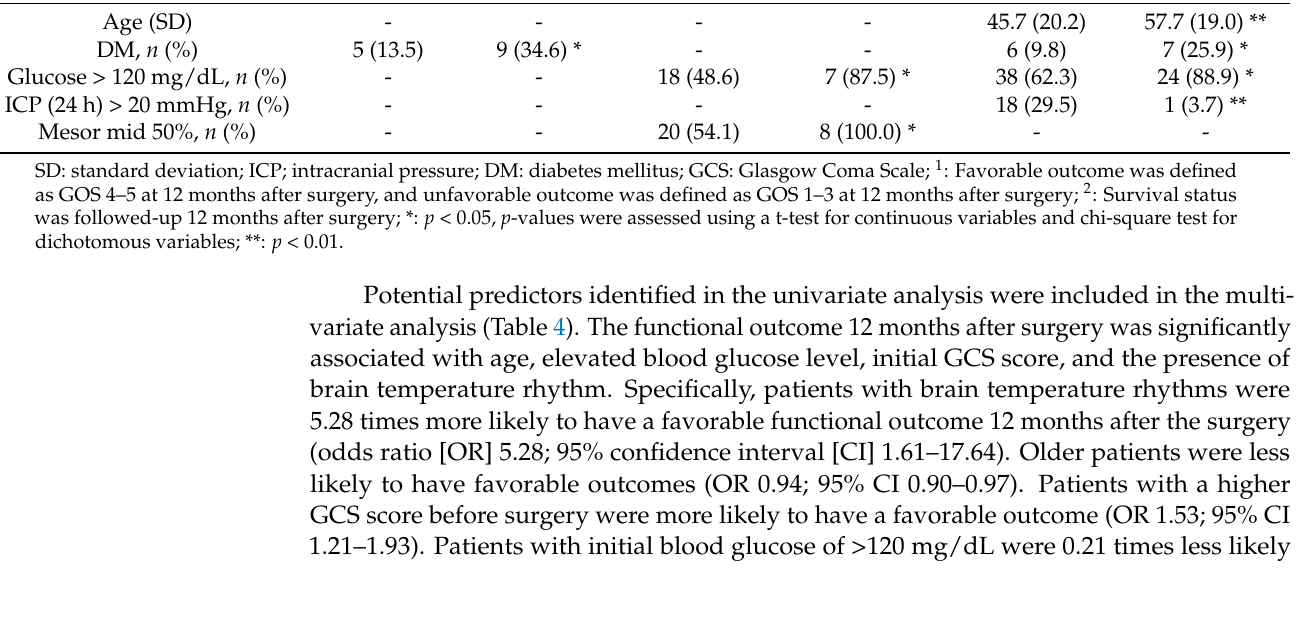
The differences between male and female patients for all parameters were tested separately in the unfavorable, favorable, dead, and alive outcomes. The parameters with significant differences between male and female patients are shown in Table 3. Female patients with unfavorable outcomes had a significantly higher proportion of diabetes mellitus (34.6%) than male patients (13.5%); female patients with favorable outcomes had a significantly higher proportion of elevated glucose levels (87.5% > 120 mg/dL), and all their mesors were within the middle 50% of brain temperature; female patients who survived at 12 months after surgery had significantly higher average age (57.7 years), higher proportion of diabetes mellitus (25.9%), higher proportion of elevated glucose levels (88.9% > 120 mg/dL), and lower ICP (3.7% > 20 mmHg). No significant difference was found among sex in the dead outcome group. Table 3. Univariate analysis for postoperative outcomes with sex comparison. Unfavorable 1